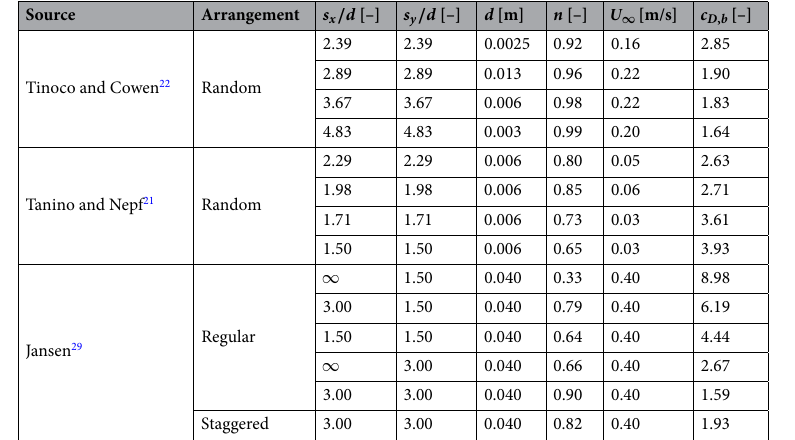
Table 1. Validation data for emergent cylinder arrays.